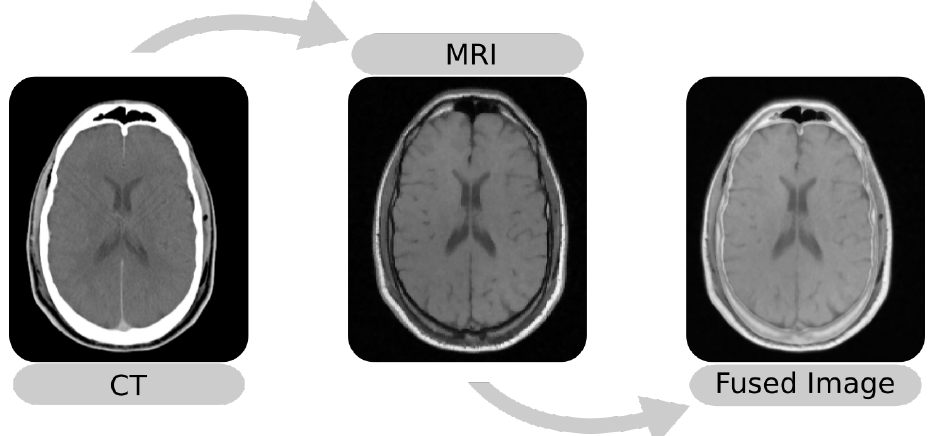
Figure 1. Example of multi-modal image fusion between an MRI and a CT. The images were taken from Patient 001 of the RIRE dataset [12].